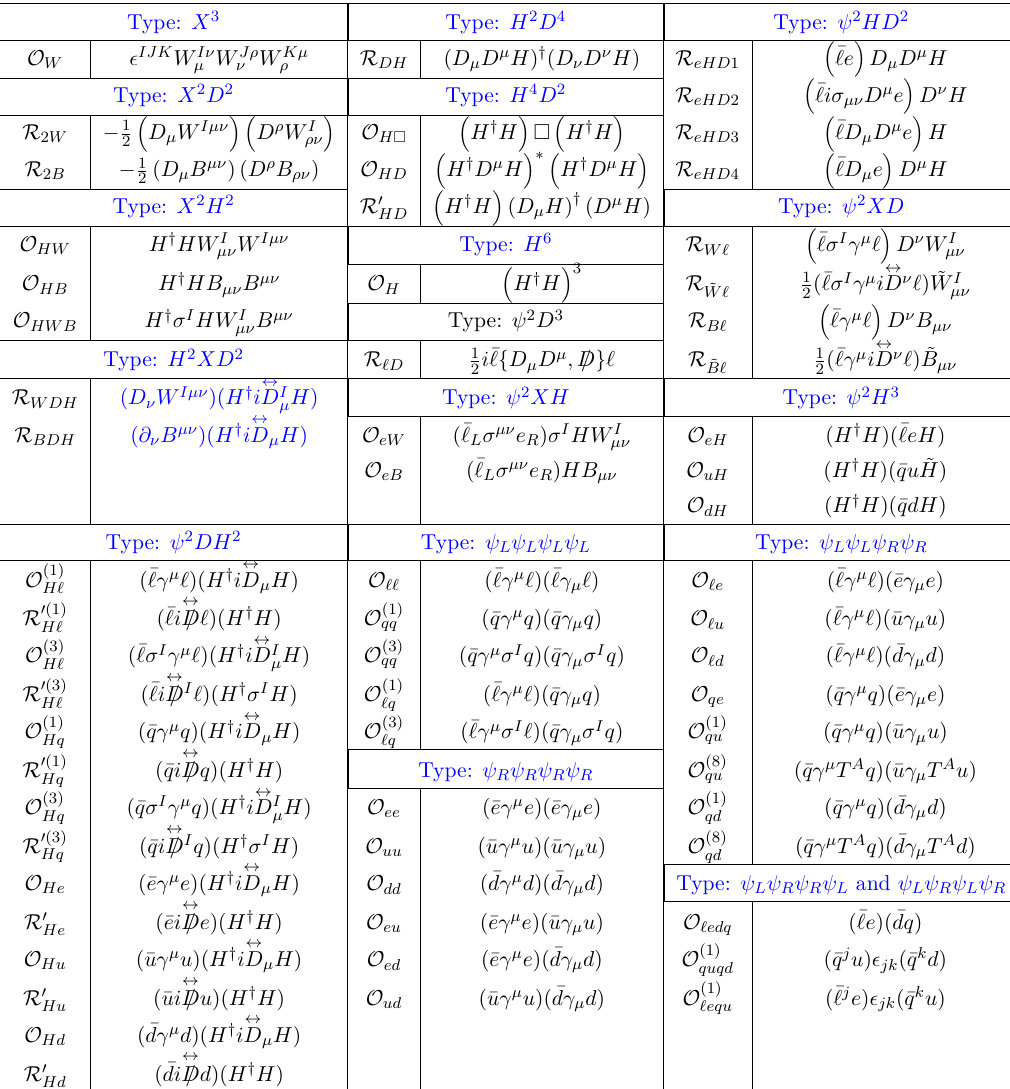
Table 13 . Operators induced by seesaw models in the Green’s and Warsaw bases. Operators in both the Warsaw basis and the Green’s basis are denoted by O , while redundant operators in the i Green’s basis are denoted by R . We classify the operators by their types as specified in blue. i Flavor indices of the fermions are labeled by their order, which is not shown in the